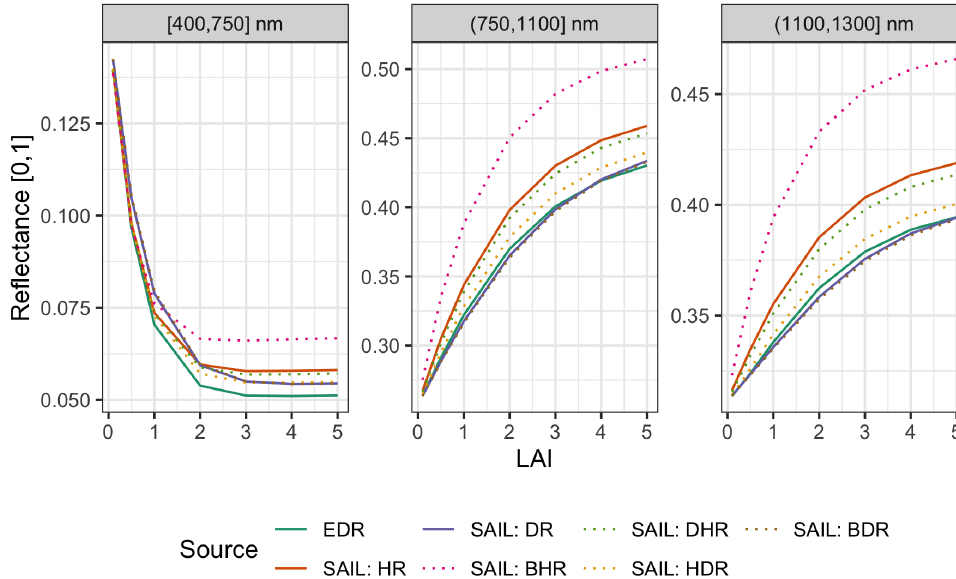
Figure A16. Same as Fig. 10 but varying LAI and fixing cos (θ s ) = 0 . 85, a typical value for our study.